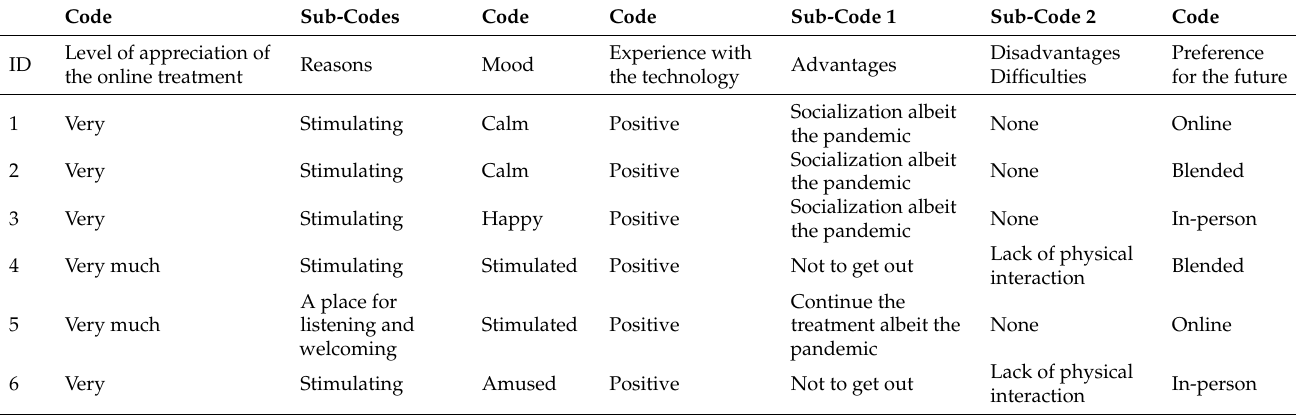
Table 3. Code and sub-codes of the qualitative contents’ analysis per participant.